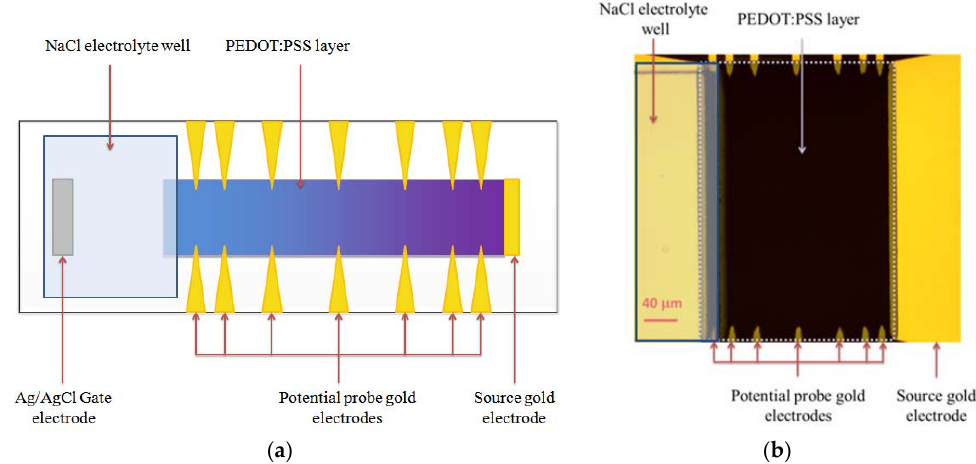
Figure 3. Experimental set up for steady state potential measurement of PEDOT:PSS channel under applied gate-source potential: ( a ) Simplified schematic representation; ( b ) Real image.